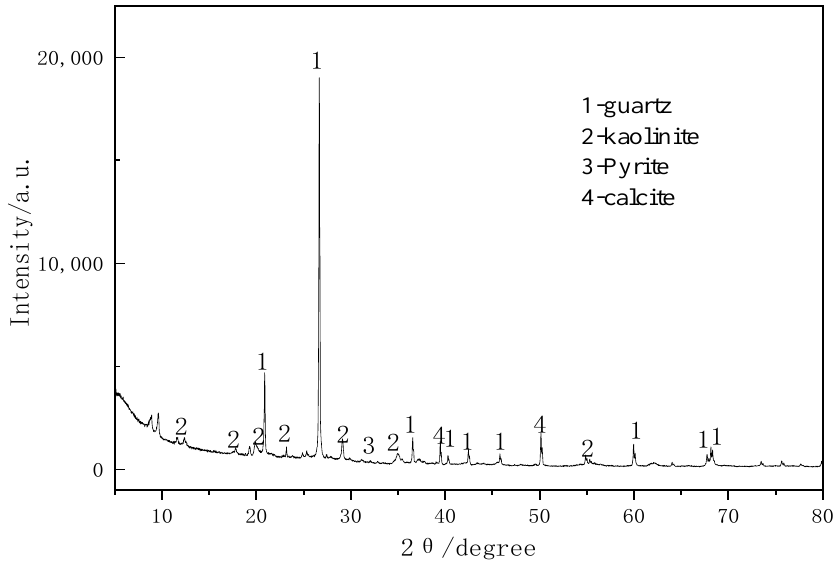
Figure 2. XRD patterns of raw coal gangue and roasted coal gangue.